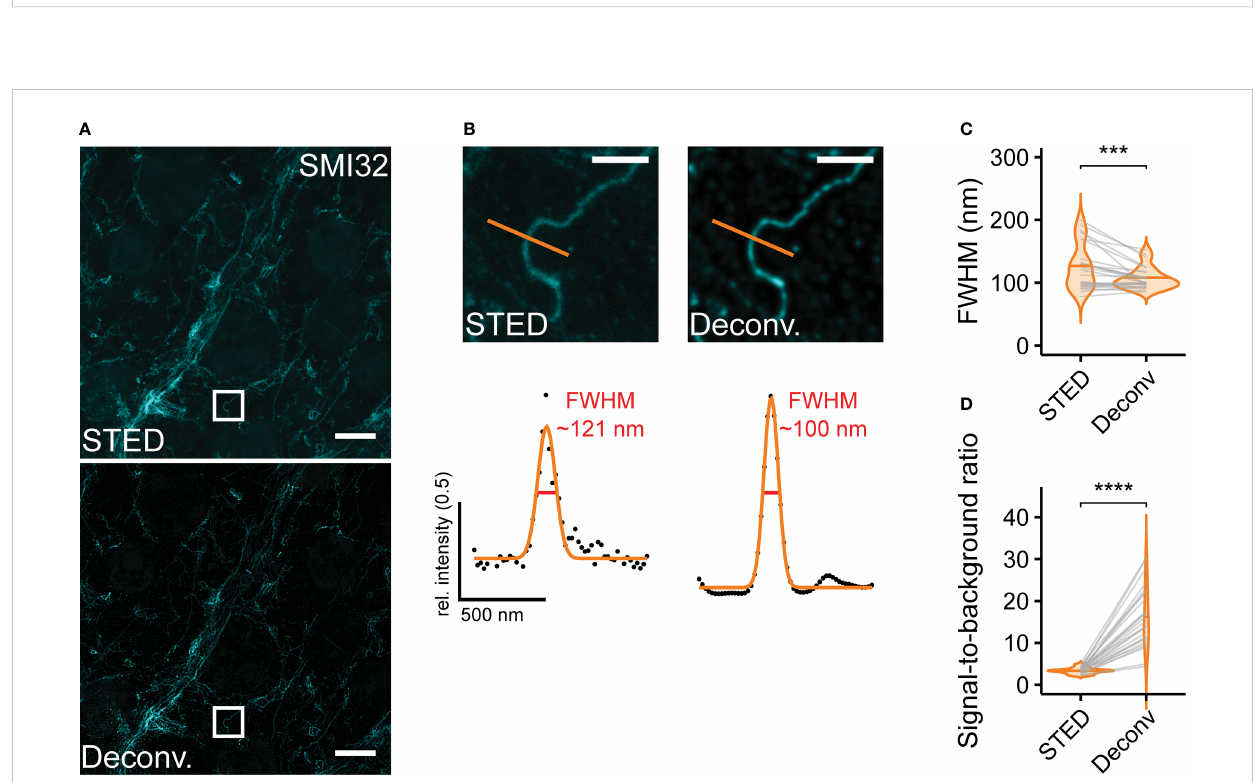
FIGURE 5 Deconvolution increases resolution and SBR for retinal ganglion cell dendrites (A) Representative example STED image without (top) and with deconvolution (bottom). (B) Top: Zoomed-in region as indicated in (A) Bottom: FWHM intensity pro fi les taken at indicated position without (STED) and with deconvolution (Deconv.) (C) Quanti fi cation of the effect of deconvolution on FWHMs (p< 0.001 = ***, Wilcoxon signed-rank test, n = 1 animal; n = 26 structures from 1 image, horizontal bars indicate means, grey lines connect corresponding values). (D) Quanti fi cation of the effect of deconvolution on SBR (p< 0.0001 = ****, paired t-test, n = 1 animal; n = 26 structures from 1 image, horizontal bars indicate means, grey lines connect corresponding values). For A and B, the excitation wavelength was 635 nm, and the dye was ATTO647N. Scale bars: 5 µm in A, 1 µm in B.